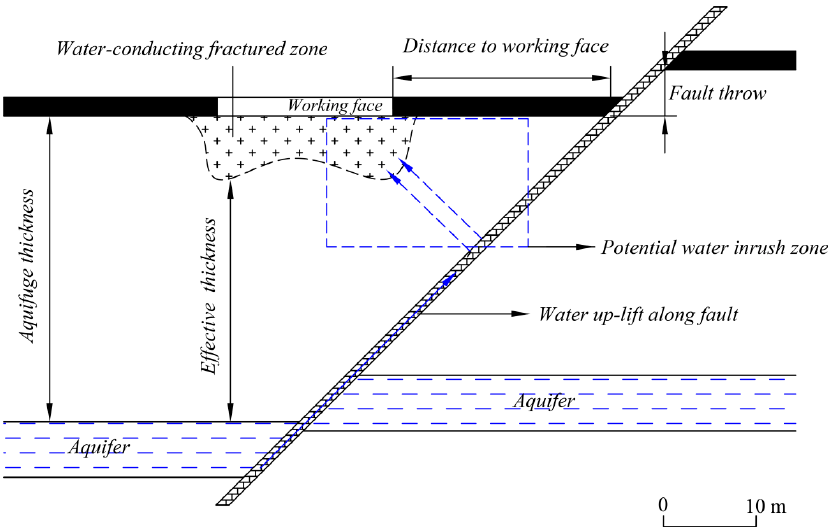
Figure 2. The coal seam and the aquifer are connected by a large fault.